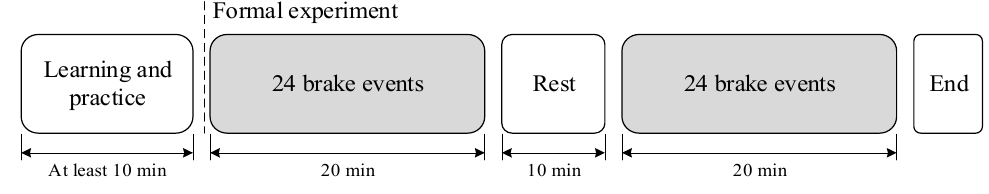
Figure 2. The experimental